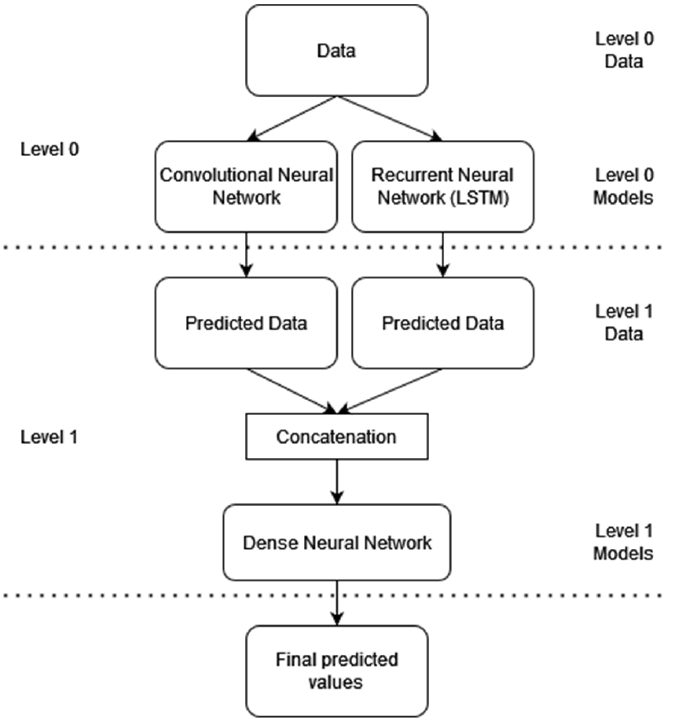
Figure 2. Illustration of the stacked ensemble model used to predict ET° values. Before the short-term prediction using deep neural networks, we used a series of 14 models to estimate evaporation for the Thomas